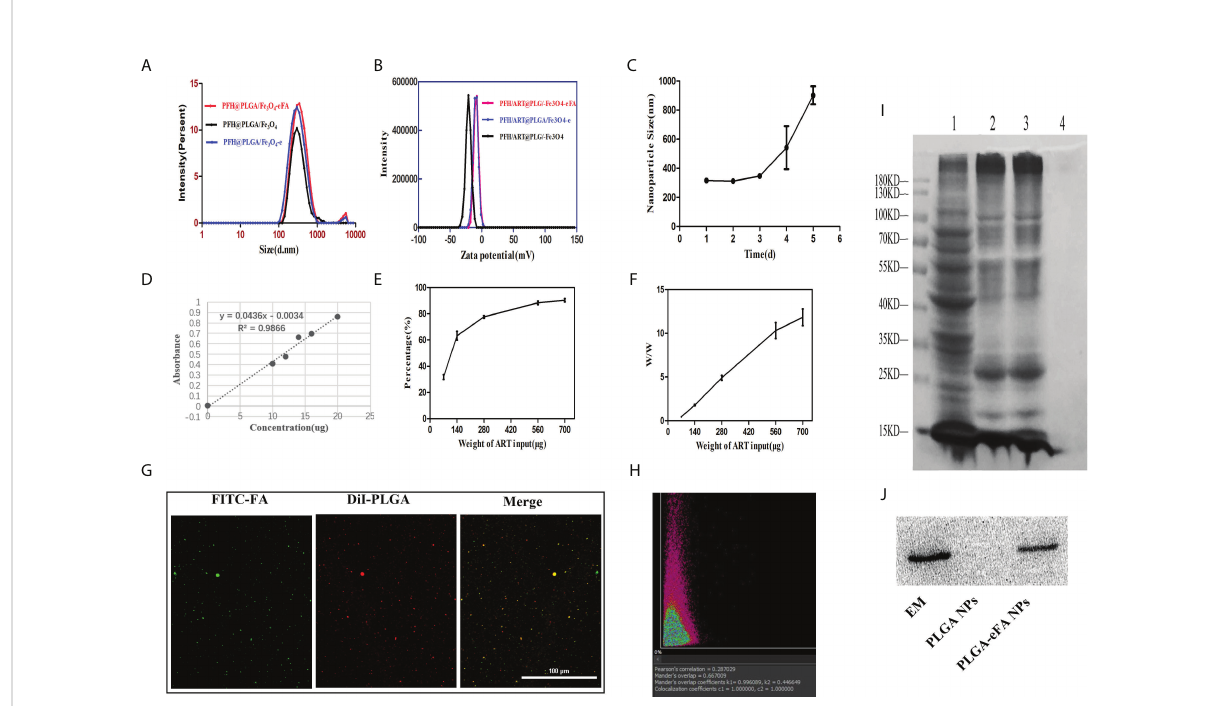
FIGURE 1 Biophysicalcharacterization of NPs. (A) Changes in the size of PFH/ART@PLGA/Fe 3 O 4 -eFA in PBS (pH 7.4) solution (B) Zeta potential of PFH/ ART@PLGA/Fe 3 O 4 , PFH/ART@PLGA/Fe 3 O 4 -e, and PFH/ART@PLGA/Fe 3 O 4 -eFA (C) Size changes of PFH/ART@PLGA/Fe3O4-eFA in PBS (pH 7.4) solution containing with 10% FBS. (D) Corresponding relationship between the concentration of ART and absorbance optical density. (E) The drug encapsulation ef fi ciency of different concentrations of ART. (F) The loading capacity of NPs with different concentrations of ART. (G) CLMS images of PFH/ART@PLGA/Fe 3 O 4 -eFA. (H) The results of the binding ef fi ciency of FA-modi fi ed EMs and PFH/ART@PLGA/Fe 3 O 4 was further validated through a quantitative assay by fl ow cytometry. (I) SDS – PAGE results of different NPs (1 representserythrocyte, 2 represents EMs, 3 represents